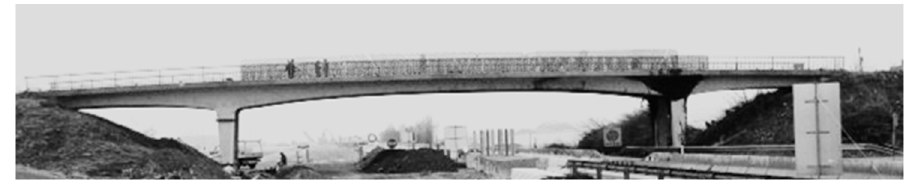
Figure 6. Bridge S101 during testing [145].